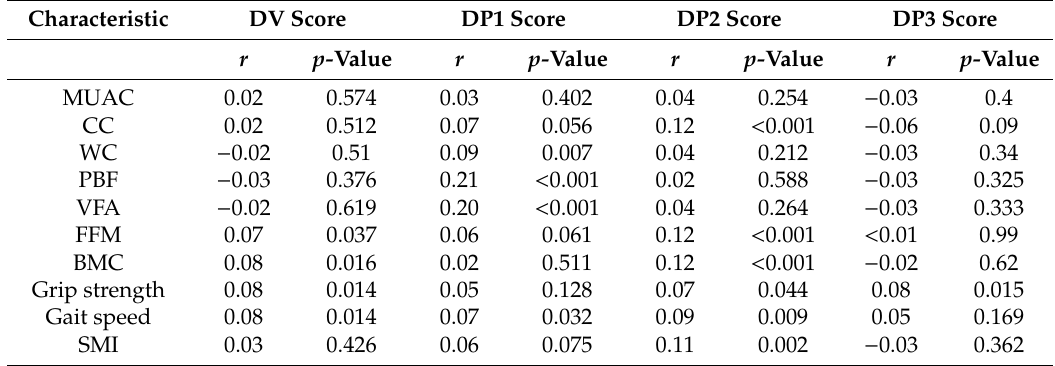
Table 3. Partial correlations between dietary variety (DV), DPs, and anthropometric characteristics.